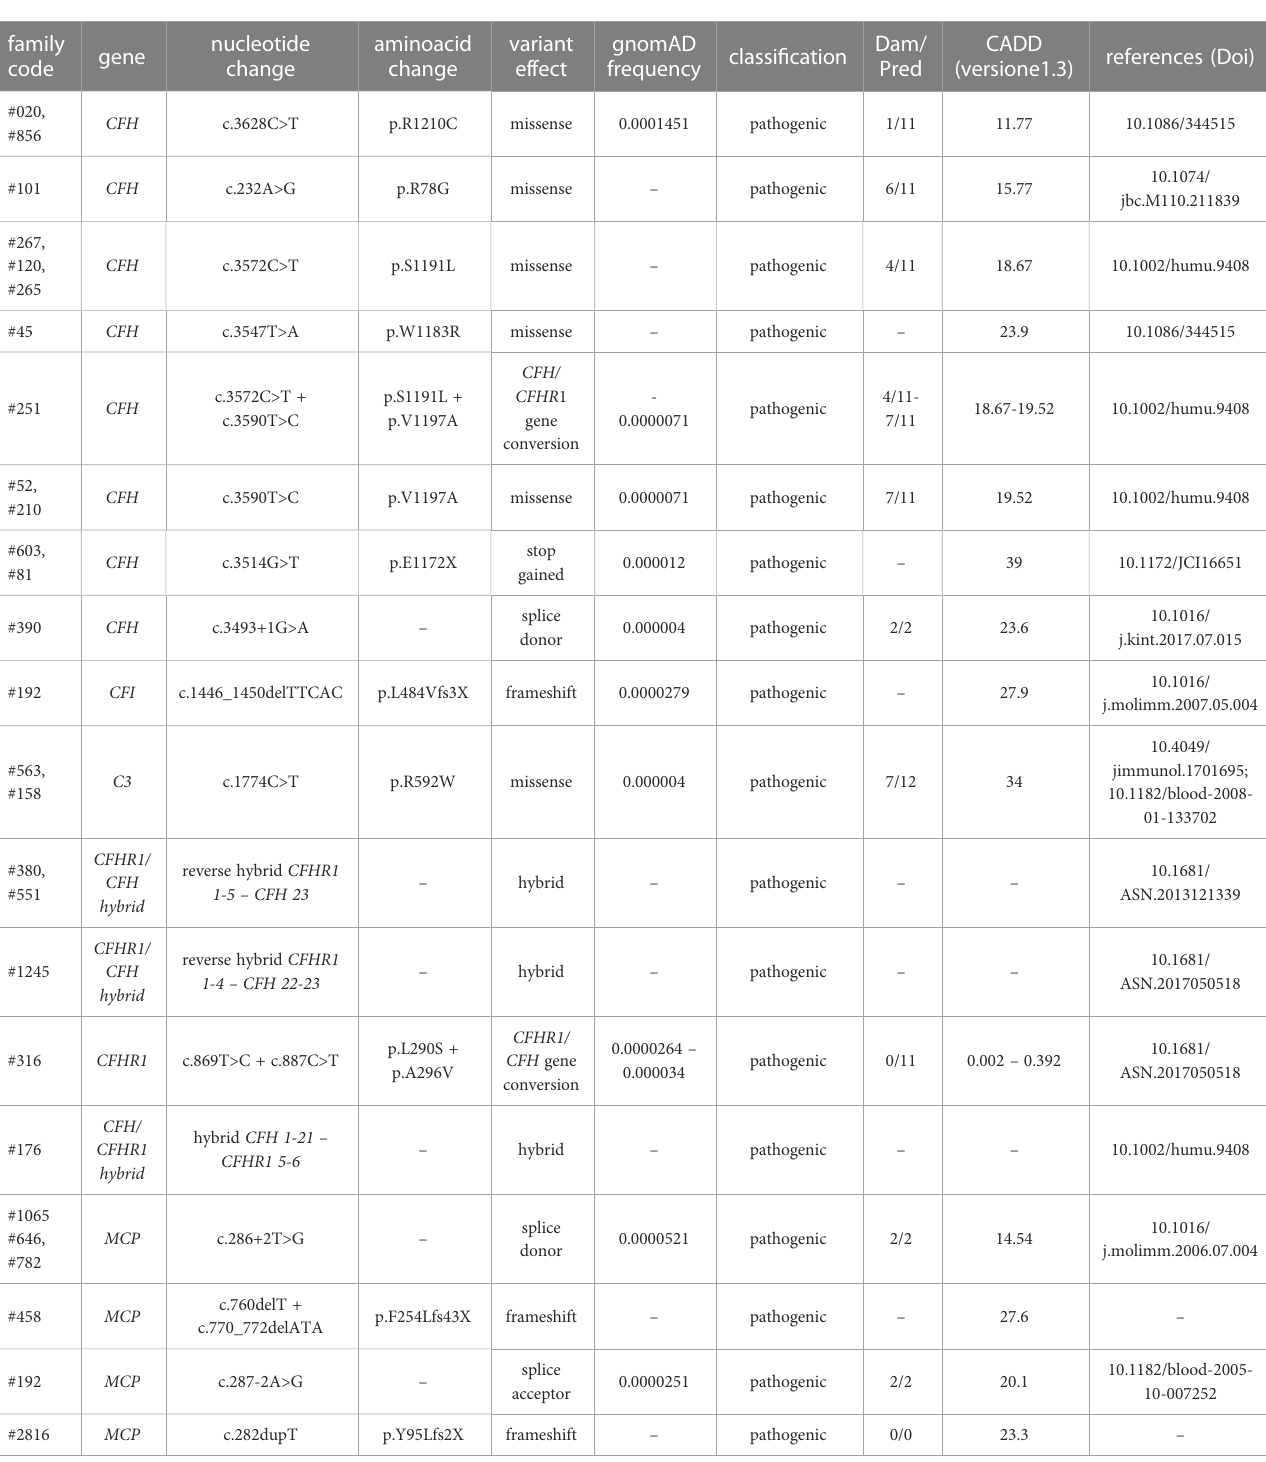
TABLE 1 List of known rare pathogenic variants (PV) identi fi ed in aHUS patients. family